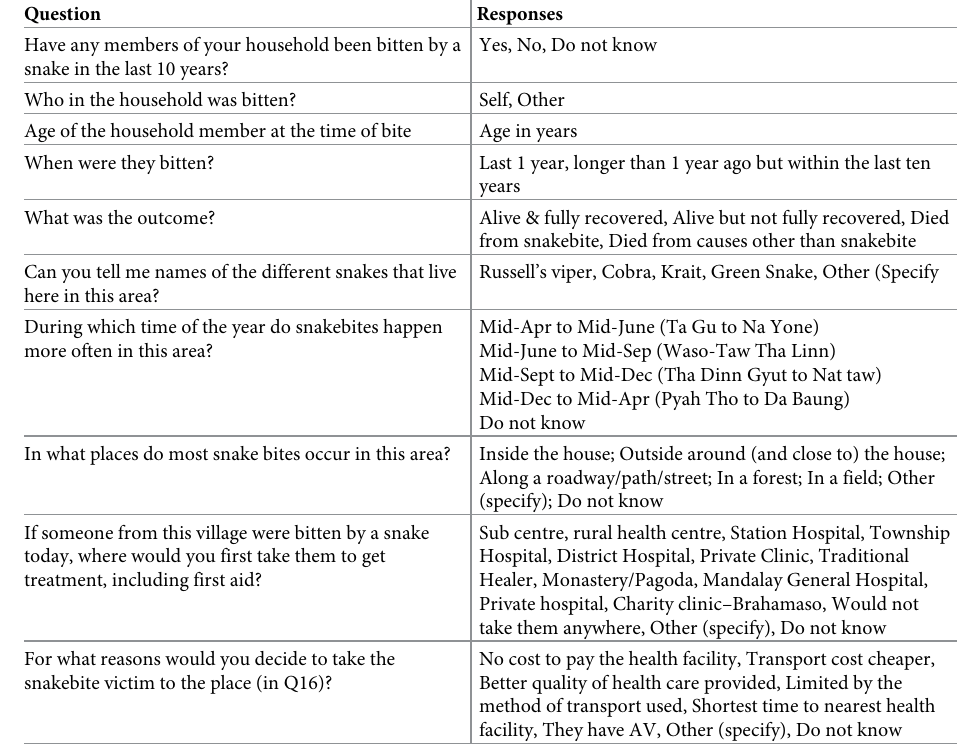
Table 1. Survey questions about incidence and outcome. Question